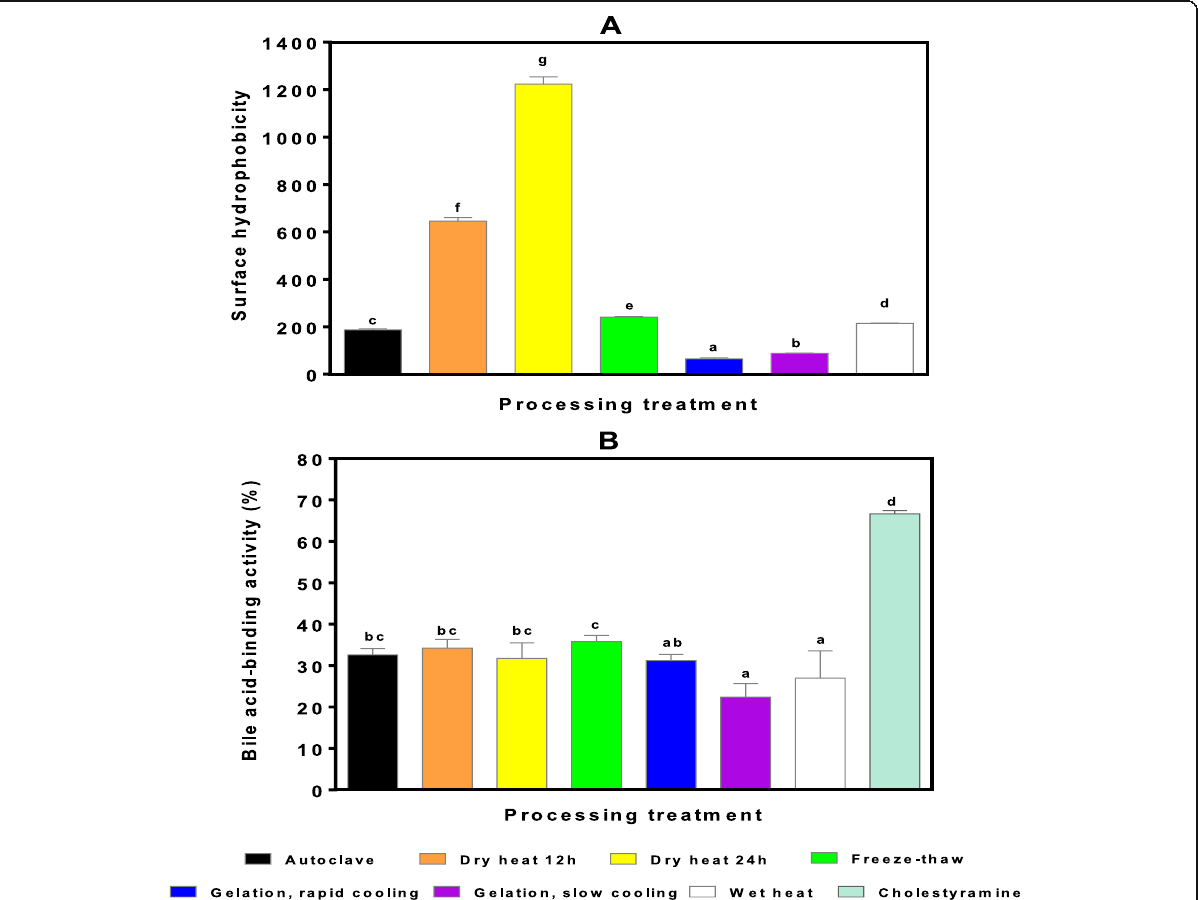
Fig. 2 a Surface hydrophobicity and b bile acid binding activity (%) of indigestible cowpea proteins obtained after pepsin + pancreatin digestion of cowpea protein isolate pretreated with autoclave, 12 h dry heat, 24 h dry heat, freeze-thaw (3 cycles), gelation (rapid cooling), gelation (slow cooling), or wet